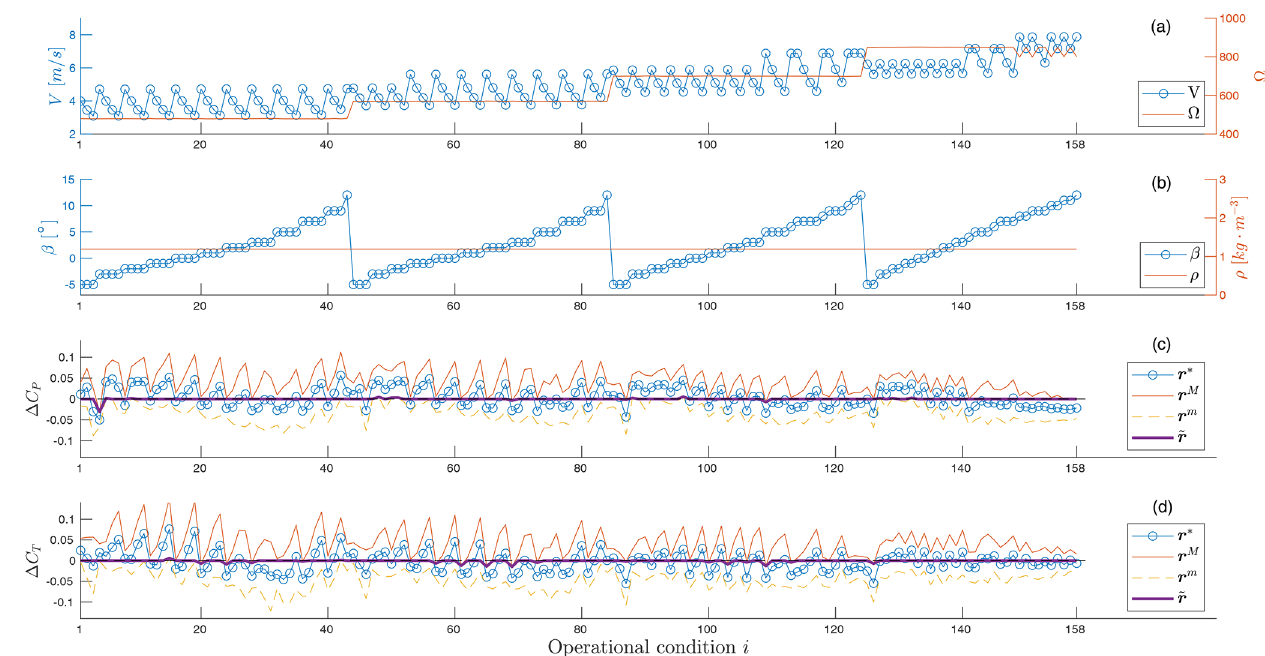
Figure 3. (a, b) Nominal model inputs V , (cid:127) , β , ρ . (c, d) Nominal, maximal, minimal, and filtered residuals for the two outputs (cid:49)C P and (cid:49)C T . All quantities are plotted for each one of the 158 operating conditions in the measurement